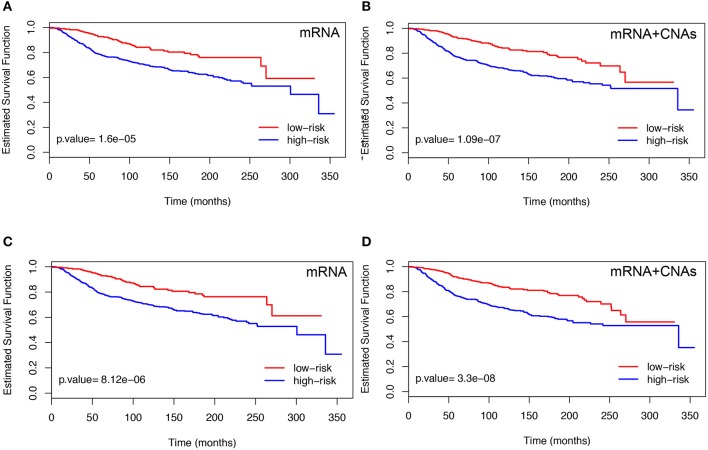
Kaplan-Meier plots obtained using mRNA data (left) and the integration of mRNA and CNAs profiles (right). The results refer to the testing set D. For each case, patients were divided into two groups according to the prognostic index by using BMD-genes with Coxnet (A,B) and ADMMnet (C,D). We use the color blue to indicate the high-risk group and the color red to show the low-risk group. The p-value is also calculated applying the log-rank test on testing set. The high-risk group is better separated from the low-risk group by using the integration of mRNA expression data and CNAs profiles (right), compared with using the single omics data (left). The X-axis represents time and the Y-axis represents survival rate.